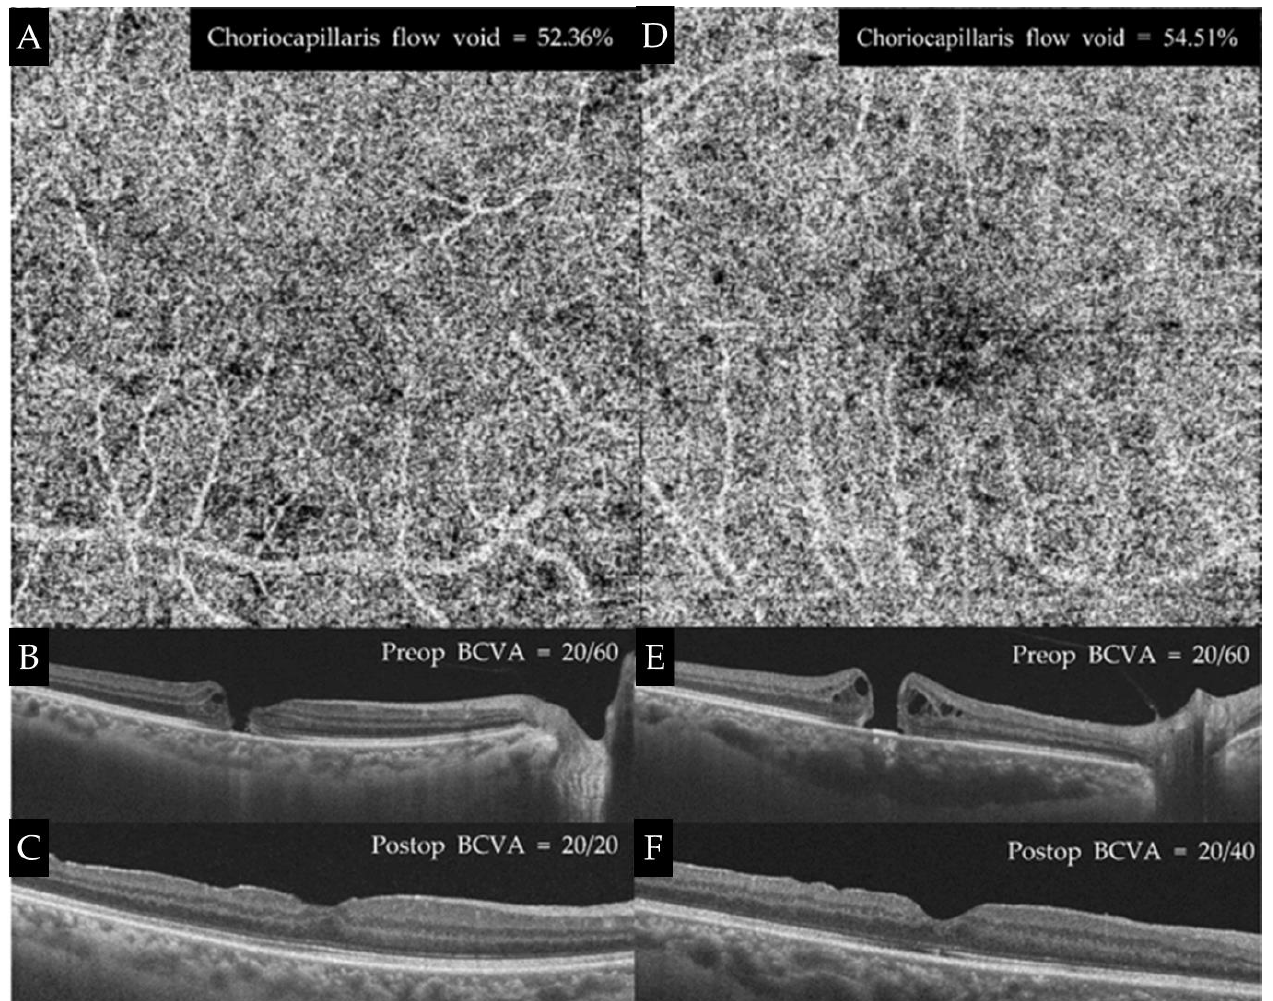
Figure 6. Comparison between the nearly recovered and partially recovered groups. A 63-year-old man showed anatomic and functional restoration after macular hole surgery. Choriocapillaris flow void was 52.36% postoperatively (A). His vision was 20/60, and OCT revealed FTMH (B). Six months postoperatively, his vision was restored to 20/20, and there was no discontinuity in both the EZ and ELM line (C). A 73-year-old woman underwent macular hole surgery due to FTSSMH (D), and her preoperative BCVA was 20/60. Some discontinuity in the EZ line was left (E). Postoperatively, her vision was 20/40, and choriocapillaris flow void was 54.51% (F). Table 3. Comparison between the retinal thickness of eyes with full thickness macular holes six months postoperatively and unaffected eyes.